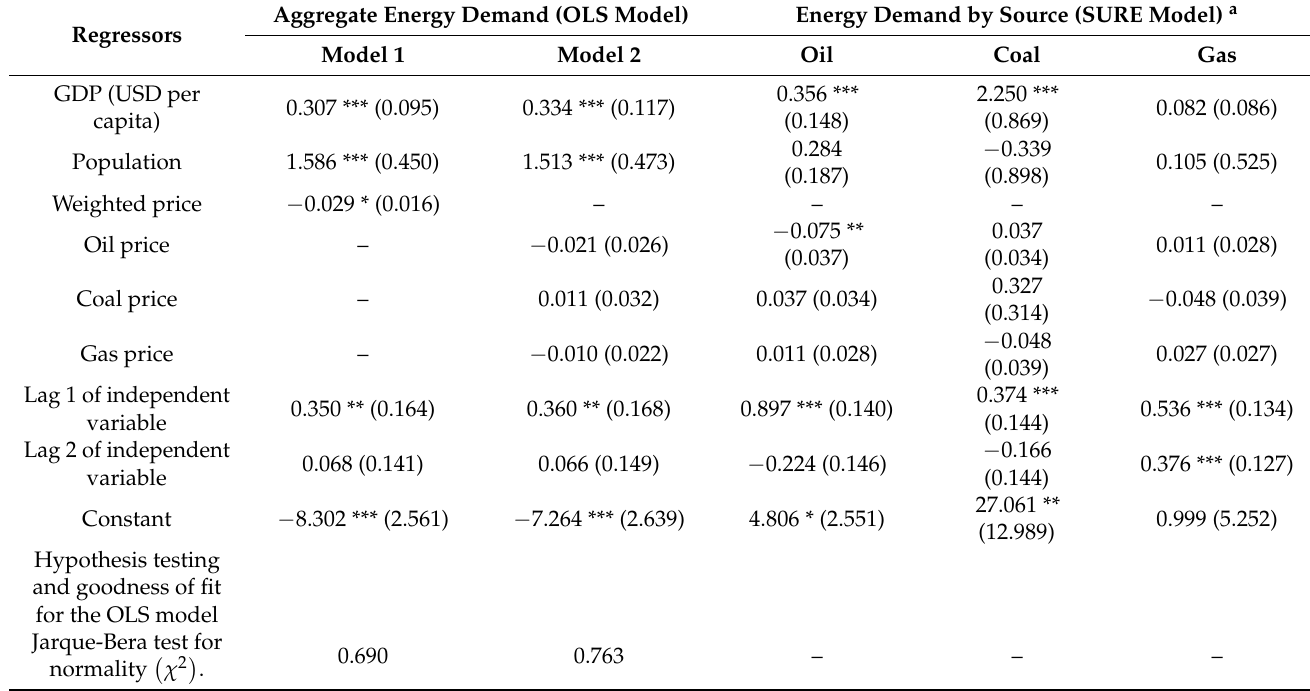
Table 3. Parameter estimates and model diagnostics for energy demand by